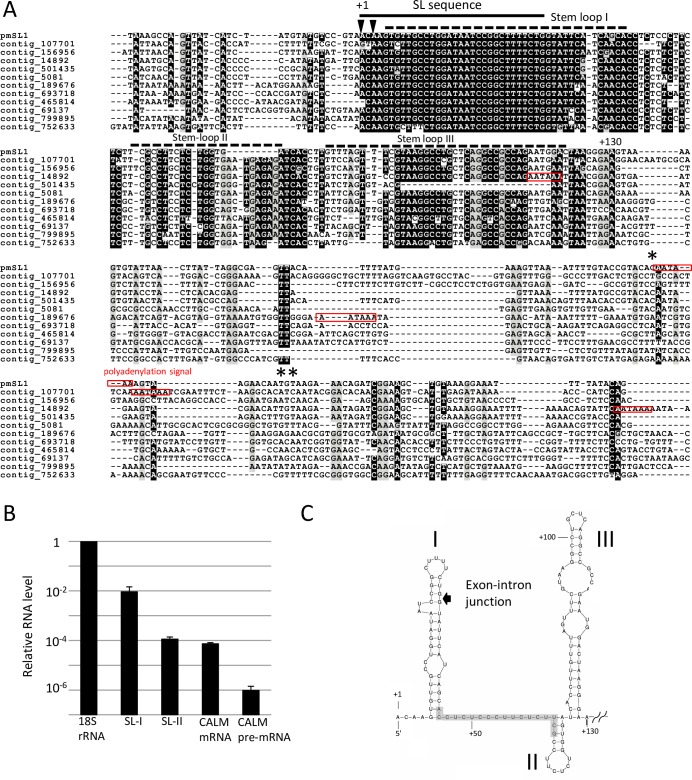
Characteristics of SL RNA genes in P. micropora.A. ClustalW alignment of SL-I RNA gene candidates. pmSL1 represents the Sanger sequence of a PCR-amplified clone, and the others are de novo assembled contig sequences from P. micropora genomic shotgun sequencing. Transcription start sites (arrowheads) of pmSL1 were determined by 5′ end mapping of cap-trapper cDNA reads, and the cleavage sites (asterisks) were determined by 3′ RACE analysis. Canonical poly(A) signals (AATAAA) are indicated by red boxes. The regions forming the stem-loop structure in pmSL1 are represented by dashed lines. B. Relative levels of SL-I RNA, SL-II RNA, and calmodulin (CALM) mRNA to 18S rRNA. Bulk expression levels of SL-I and SL-II genes (S2 Fig) were analyzed by real-time RT-PCR using conserved sequences of the respective SL RNA gene group. C. Secondary structure of the conserved region of pmSL1 RNA predicted by Mfold [46]. The shaded area indicates the candidate of Sm binding site, when the consensus rule is loosened to pyrimidine rich sequence sandwiched by adenosine and guanosine.